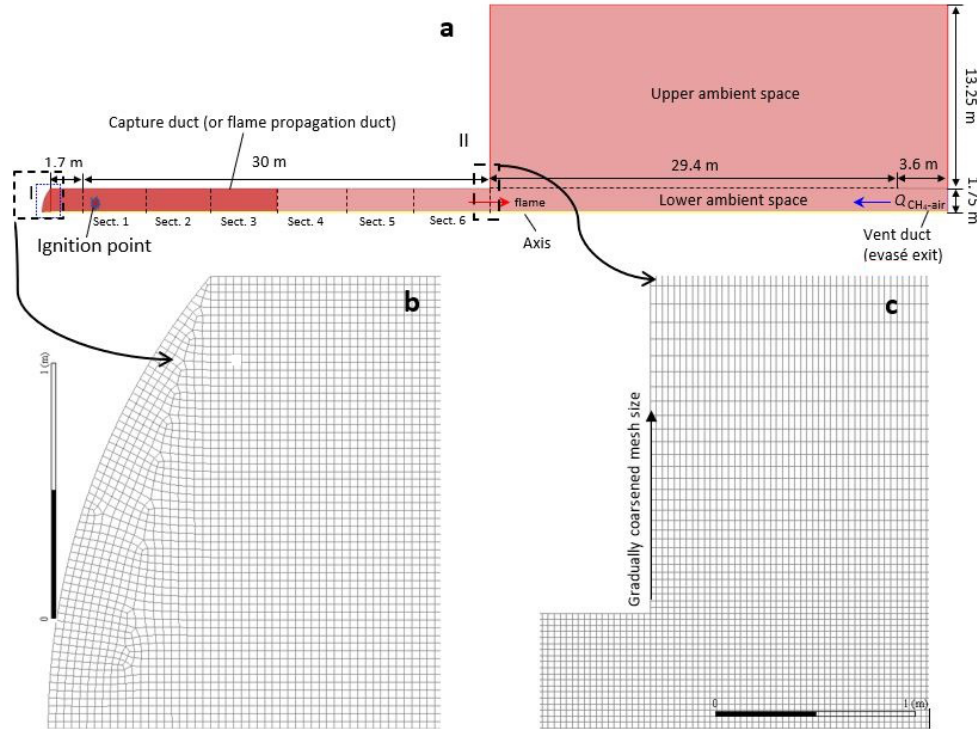
Figure 1. Computational domain and mesh of VAM plant: ( a ) view and measurements of the computational domain; ( b ) meshing of the dome section marked as region-I ; ( c ) a close-up view of the mesh of the marked region-II. The flow rate of methane–air mixture released from the evasé ( Q CH ) is 180 m 3 /s. In sections 1-3 and the dome section, the stoichiometric methane concentration 4 is present; sections 4-6 and the lower ambient space connecting the capture duct and the evasé are filled with different methane concentrations (5–9.5%), indicated by the different